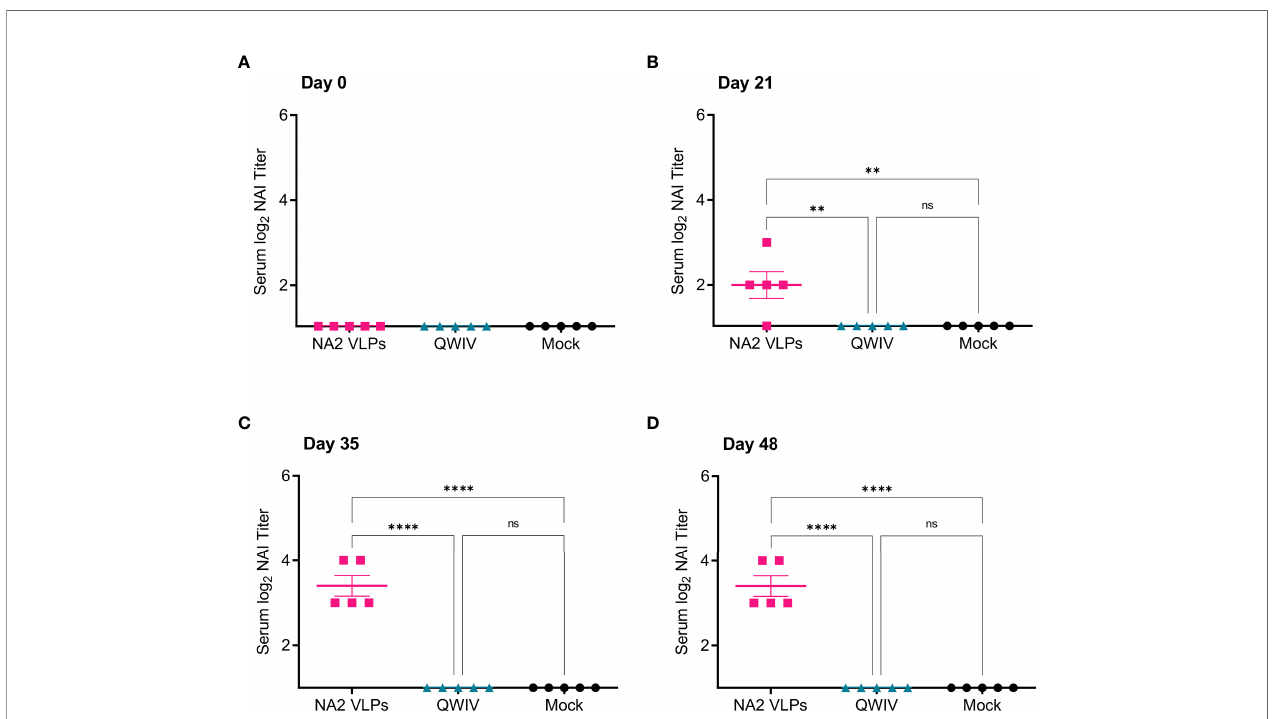
FIGURE 3 | Vaccination with NA2 VLPS induces functional anti-NA antibodies capable of inhibiting A/swine/NC/KH1552516/2016 NA activity in vitro . Three groups of pigs (n=5) were vaccinated in a prime-boost regimen 21 days apart at day 0 and day 21 with a commercial QWIV, NA2 VLPs, or mock vaccinated with water-in- oil-in-water adjuvant only (Mock). Serum was collected on day 0 before prime vaccination, day 21 at boost vaccination, day 35, and at day 48. Neuraminidase inhibition (NAI) titers were de fi ned as the reciprocal of the dilution inhibiting at least 50% of the NA activity of A/swine/NC/KH1552516/2016 virus. (A) NAI titers at day 0 prior to prime vaccination. (B) NAI titers at day 21 prior to boost vaccination. (C) NAI titers two weeks post-boost vaccination on day 35. (D) NAI titers prior to virus challenge with A/swine/NC/KH1552516/2016 on study day 48. Horizontal bars represent the mean NAI titer for each respective group. Statistical analysis was performed by one-way ANOVA test. ** = p < 0.01; **** = p < 0.0001; ns = no statistical